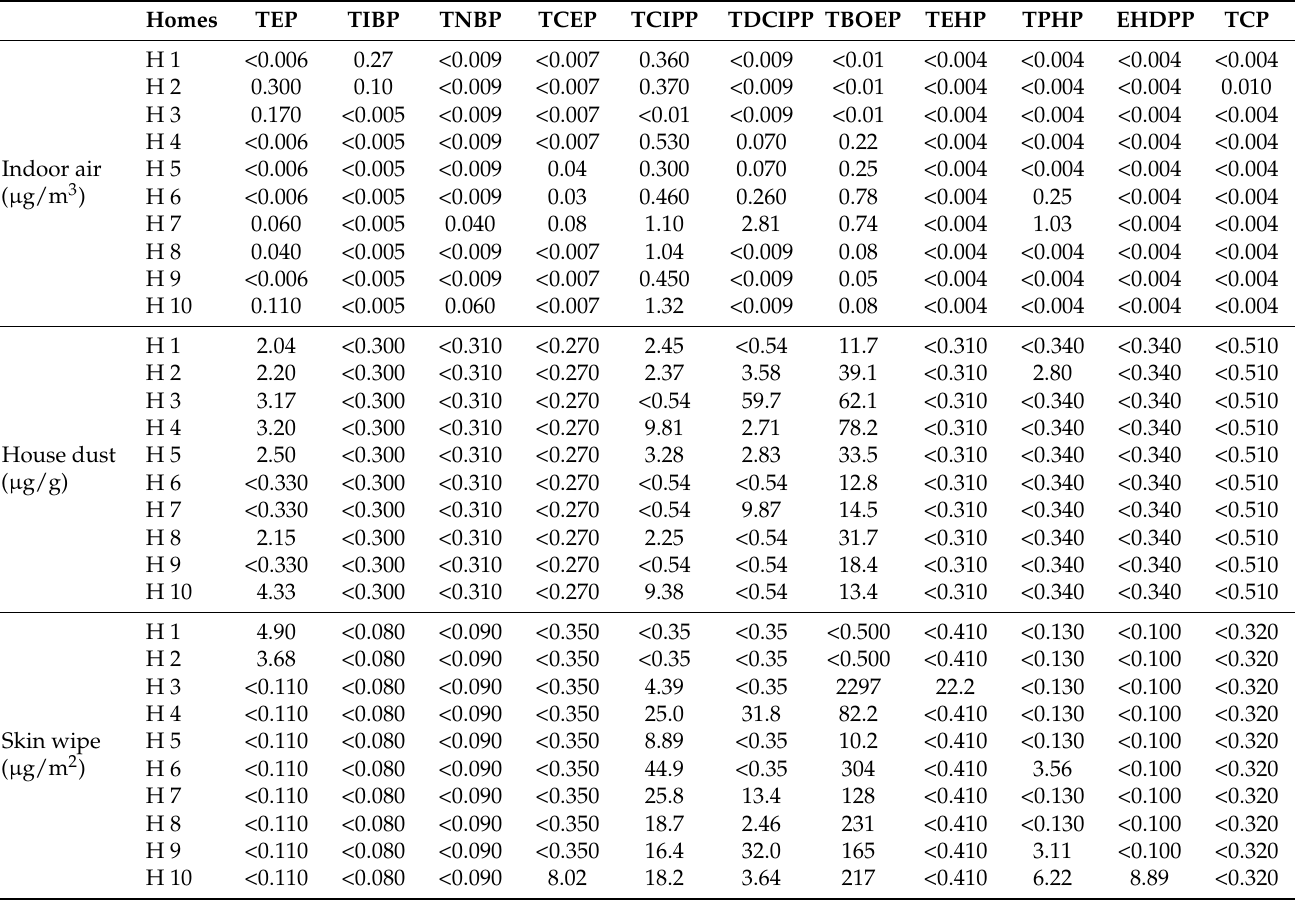
Table 3. Analysis results of real indoor air, house dust and skin wipe samples from children and their